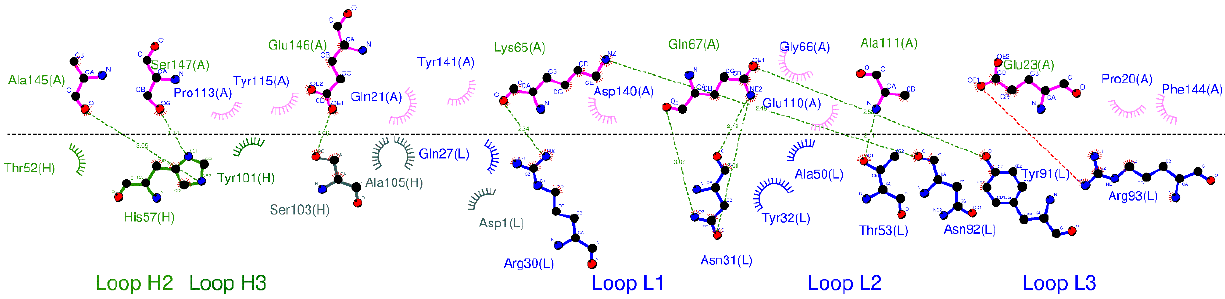
Figure 2. Binding mode analysis of Humira–TNF alpha (PDB ID: 3WD5; H: heavy chain; L: light chain; A: TNF alpha).